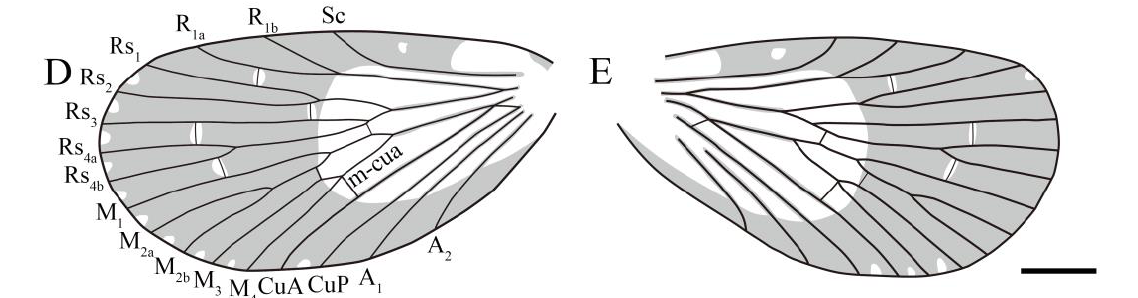
Figure 7. Line drawings of Sinoagetopanorpa lini sp. nov., NIGP200916 (holotype). ( A ) Line drawing of general habitus; ( B ) Line drawing of left forewing; ( C ) Line drawing of right forewing; ( D ) Line drawing of left hind wing; ( E ) Line drawing of right hind wing. Scale bar represents 1 mm.